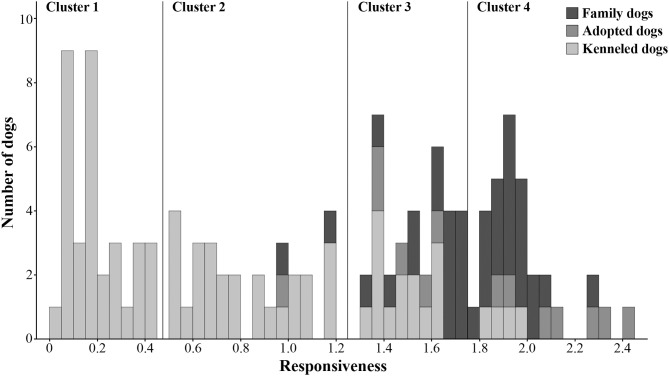
Histogram of Responsiveness. The four clusters identified by hierarchical cluster analysis are separated by horizontal lines. The three dog groups (family, adopted, kenneled) are shown in different colors.